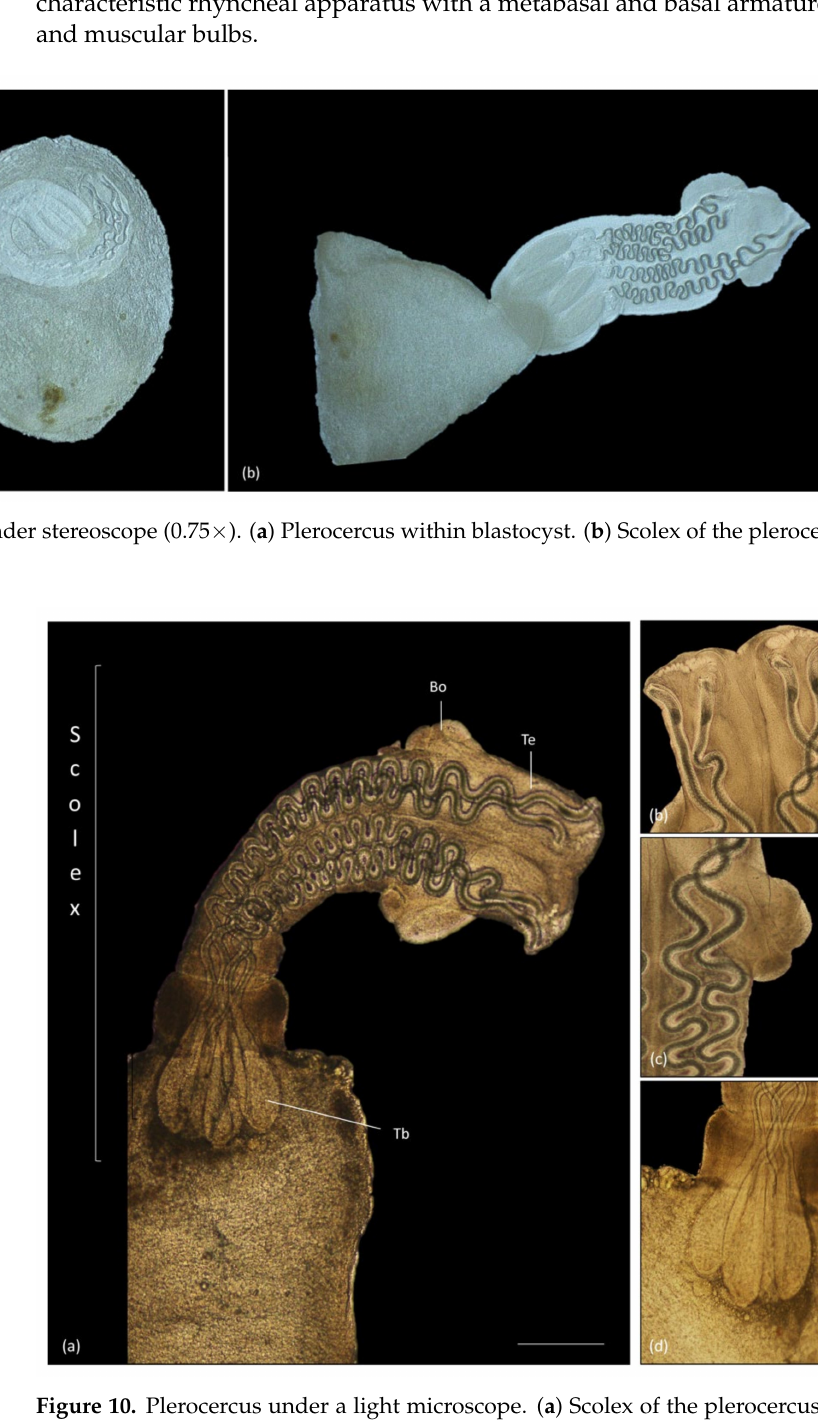
Figure 10. Plerocercus under a light microscope. ( a ) Scolex of the plerocercus emerging from the blastocyst (Bo—bothridium; Tb—tentacle bulb; Te—tentacle) (scale bar = 500 µ m). ( b ) Detail of the hooked tentacles. ( c ) Detail of the bothridium. ( d ) Detail of the tentacle